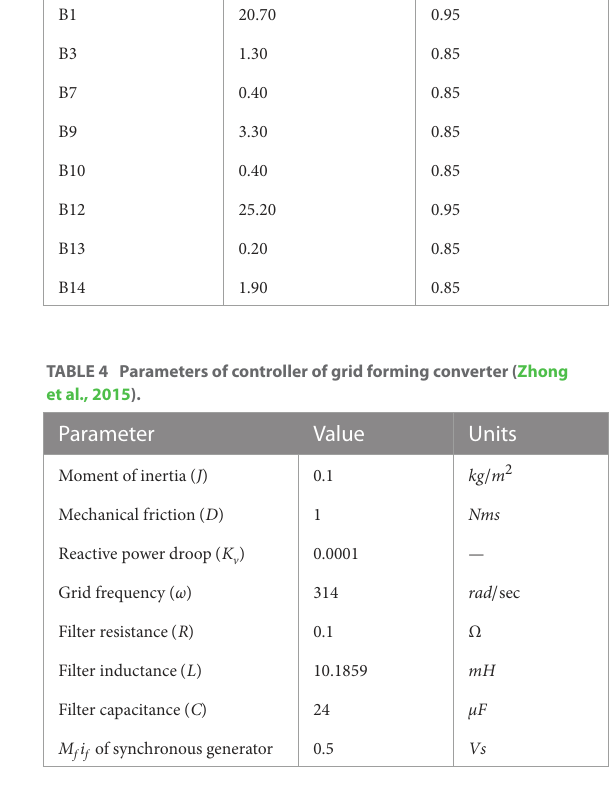
TABLE1 MVdistributionnetworkbenchmarkapplication:parameters ofPVunits(Barsali et al., 2014). Node